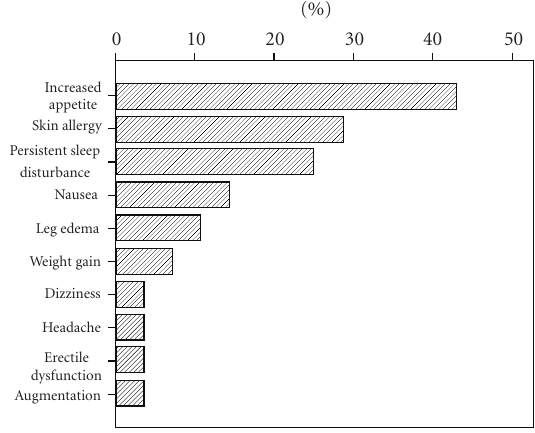
Figure 4: Adverse